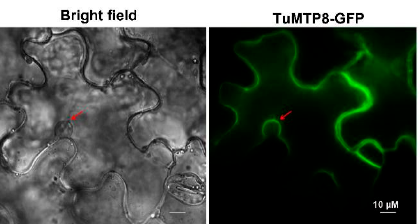
Figure 4. Subcellular localization of TuMTP8 in a tobacco epidermal leaf cell. Agrobacterium trans- formed with TuMTP8-eGFP was injected in tobacco. The tobacco was cultured in the dark for one day and in light for two days, and then was screened. The figure exhibits the bright-field ( Left panel ) and eGFP fluorescence ( Right panel ). The arrow indicated cell nucleus. Scale bar = 10 μ m. Int. J. Mol. Sci. 2022 , 23 , x FOR PEER REVIEW